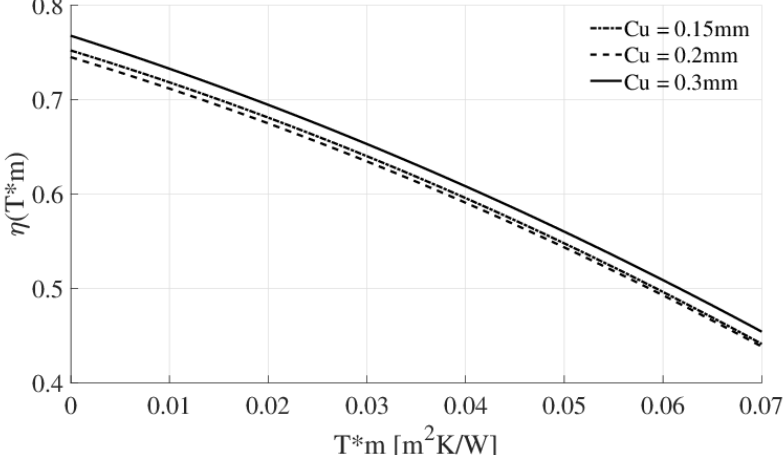
Figure 13. Experimental verification of the correlation between the thermal efficiency η ( T ∗ m ) and absorber plate thickness.